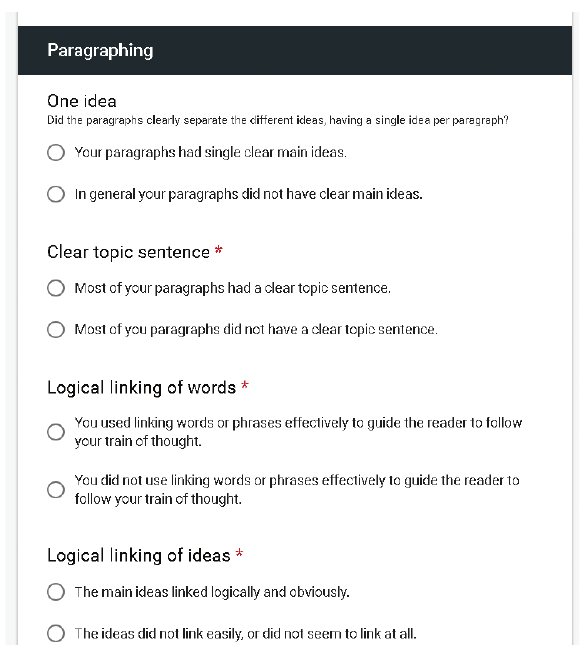
FIGURE 1: Extract from digital evaluation